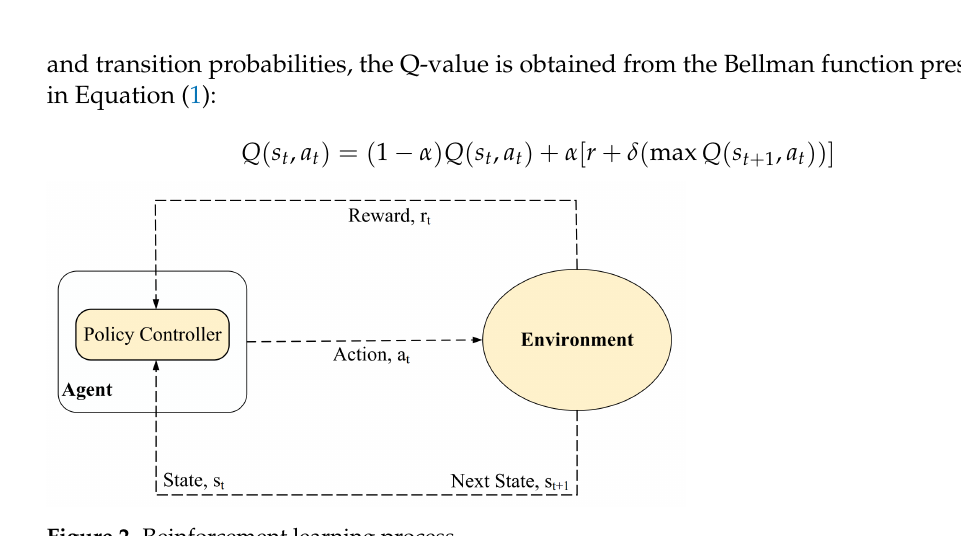
Figure 2. Reinforcement learning